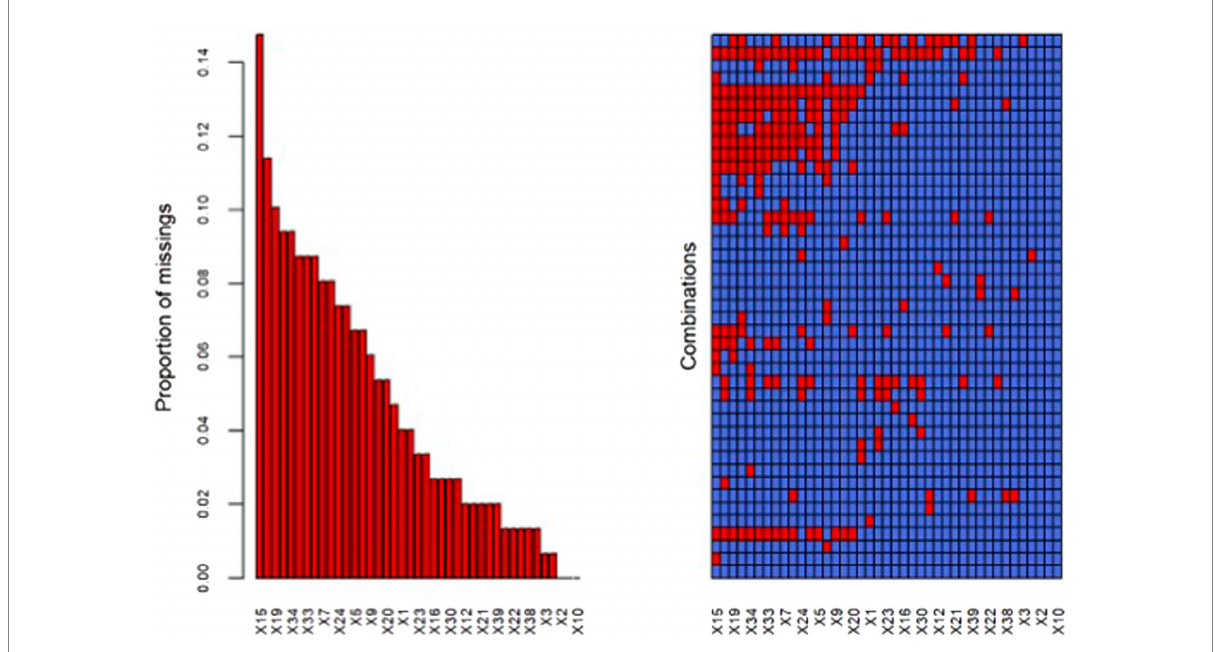
FIGURE 1 Proportion of missing data acoording to questionaire item (panel A) and missing pattern plot according to responders and items (panel